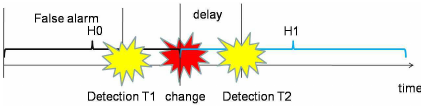
Figure 38. Illustration of detection delay and false